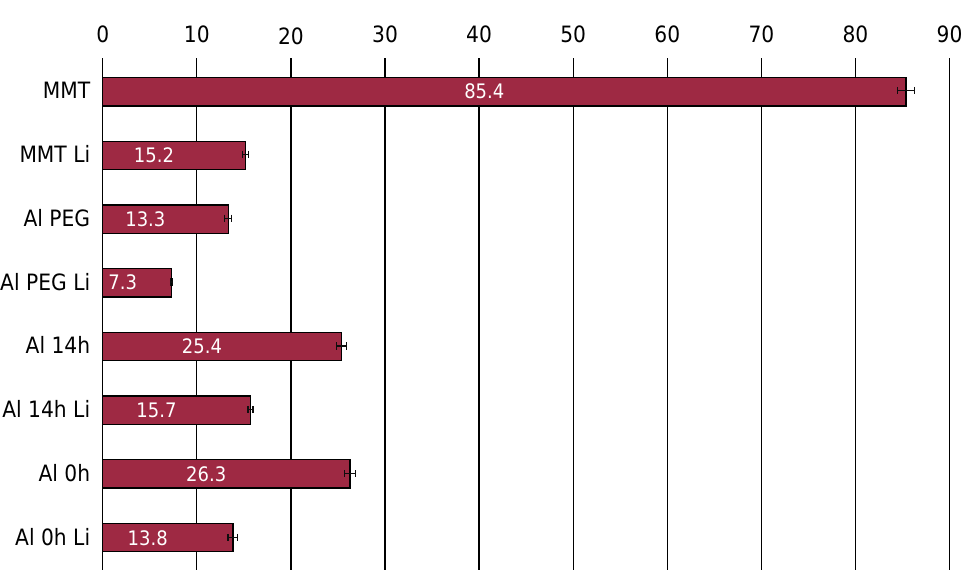
Figure 10. Cation Exchange Capacity of the samples. The dashes in the bars mean the standard deviation of the